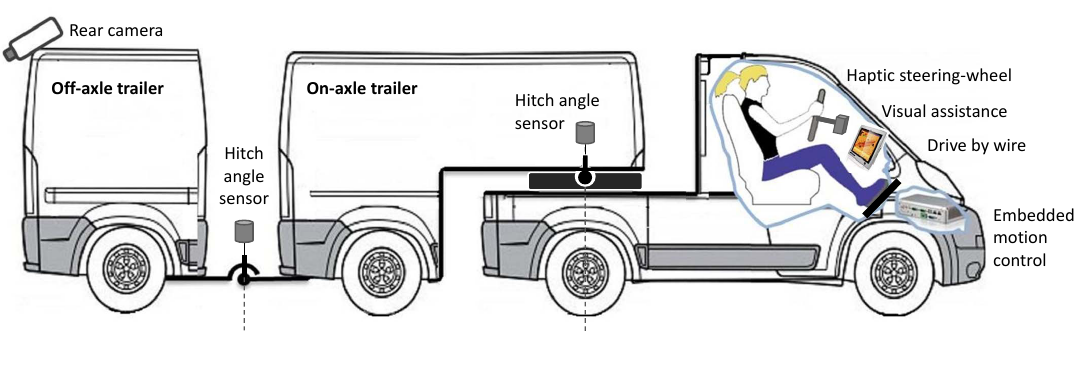
Figure 2. Overview of the multi-trailer ADAS concept.